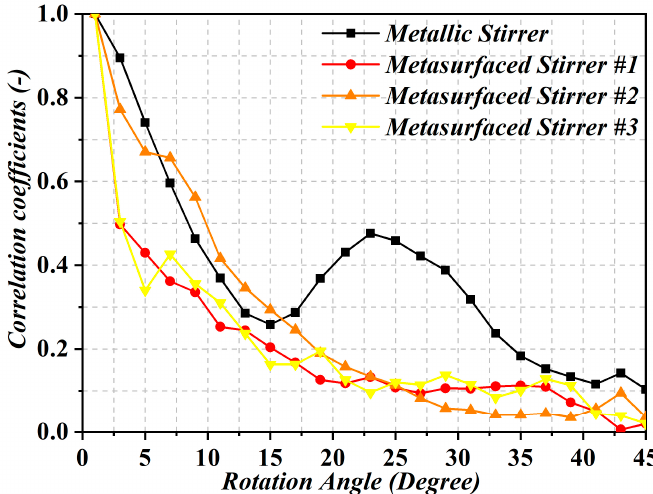
Figure 4. Correlation coefficients of the metallic and metasurfaced stirrers at 1 GHz.